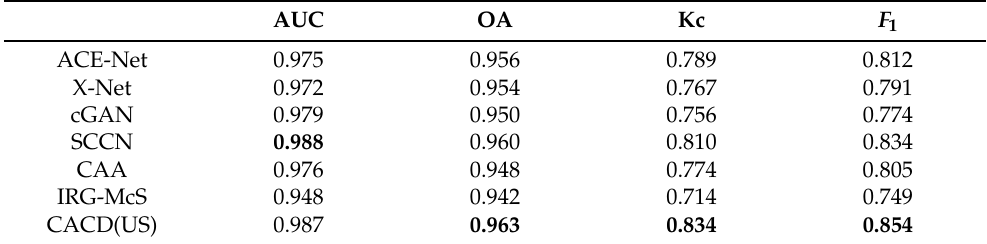
Table 5. Quantitative evaluation on the Gloucester